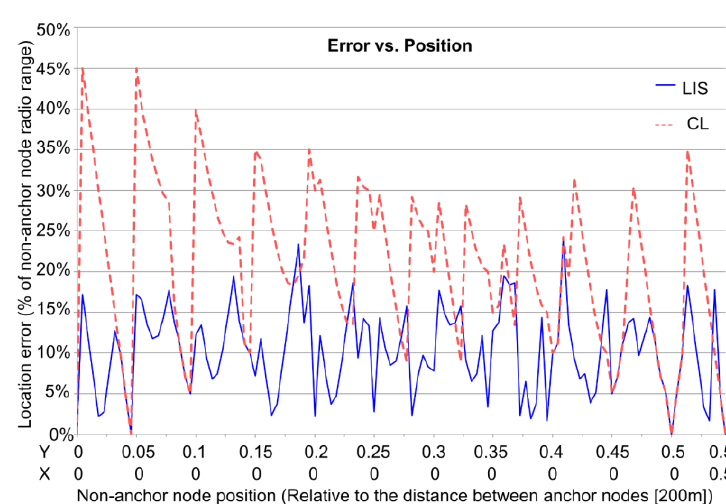
Figure 10. LIS localization